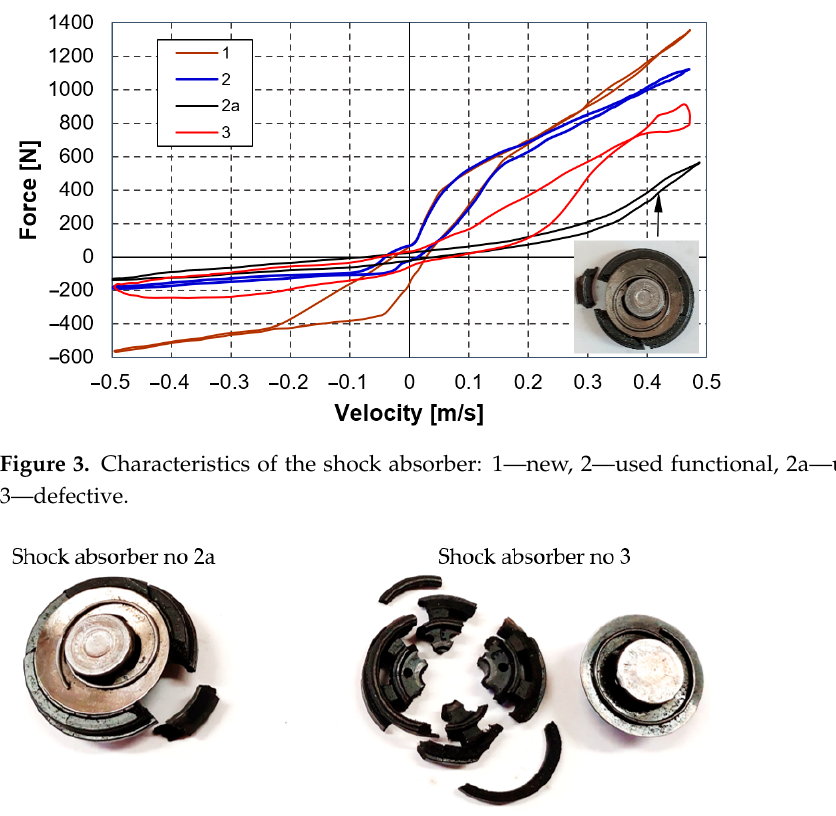
Figure 4. Defective check valves.